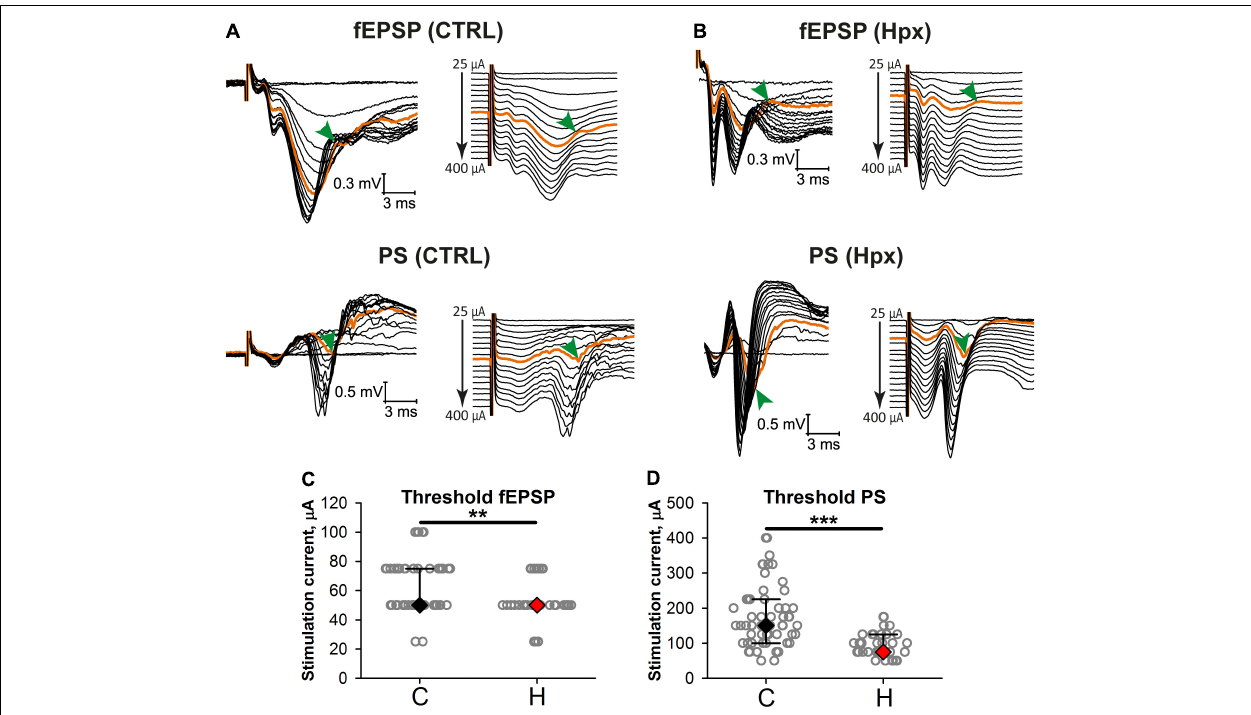
FIGURE 3 | Excitatory postsynaptic potential-spike coupling is altered in rats after prenatal hypoxia. (A,B) Representative examples of simultaneous recordings of evoked responses in stratum radiatum (top) and stratum pyramidale (bottom) to orthodromic stimulation of increasing intensity in slices from the control (A) and hypoxic (B) groups. On the right, the same recordings are shown with the shift. Orange traces are the traces with the appearance of a population spike (arrowhead). (C,D) The threshold current inducing fEPSPs (C) and population spikes (D) in slices from the control and rats after prenatal hypoxia. ** P < 0.01, *** P < 0.001—the difference between the control and hypoxic groups (Mann–Whitney test).